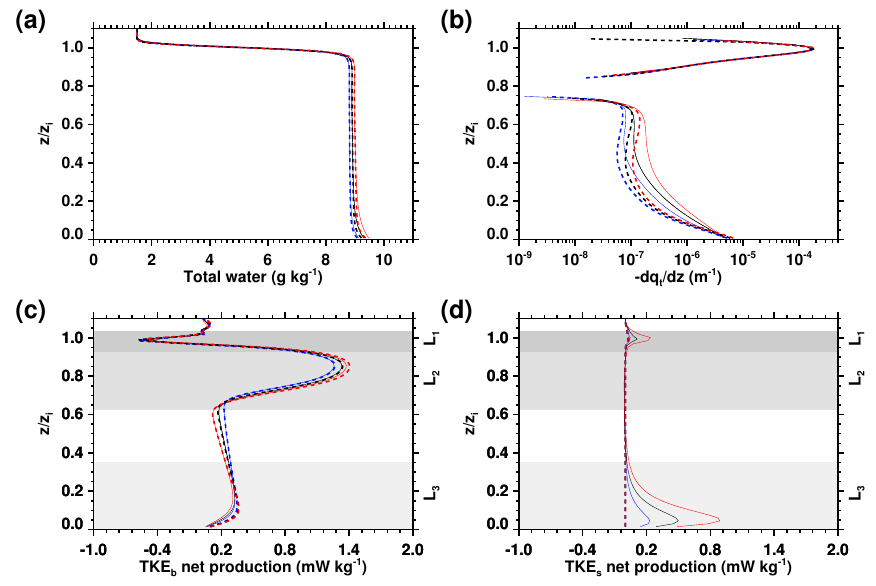
Figure 15. Buoyancy- and shear-driven dynamics. Profiles averaged over the period N (10:20–11:20UT) from simulations L − (blue), L 0 (black), L + (red), solid curves, and from simulations L − production, TKE s shear production of turbulence kinetic energy.